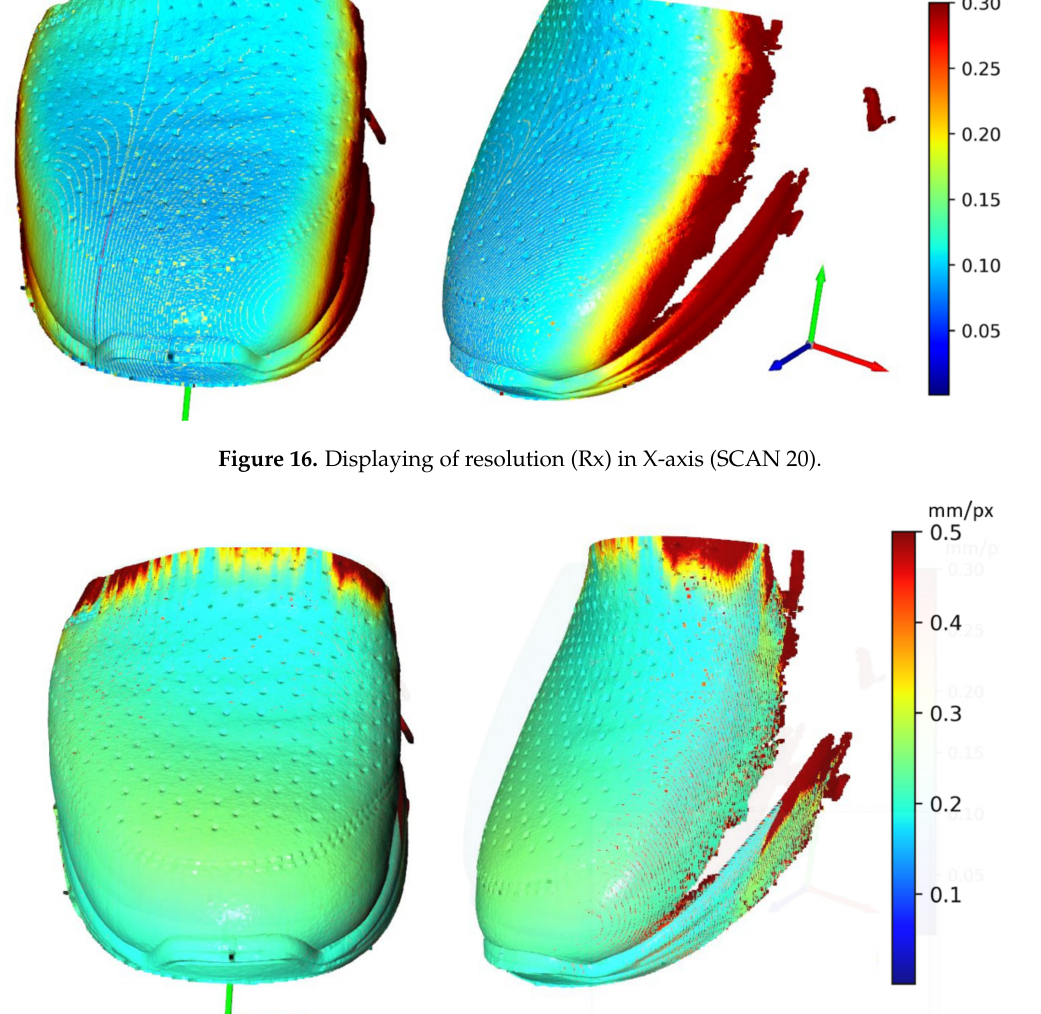
Figure 17. Displaying of resolution (Ry) in Y-axis (SCAN